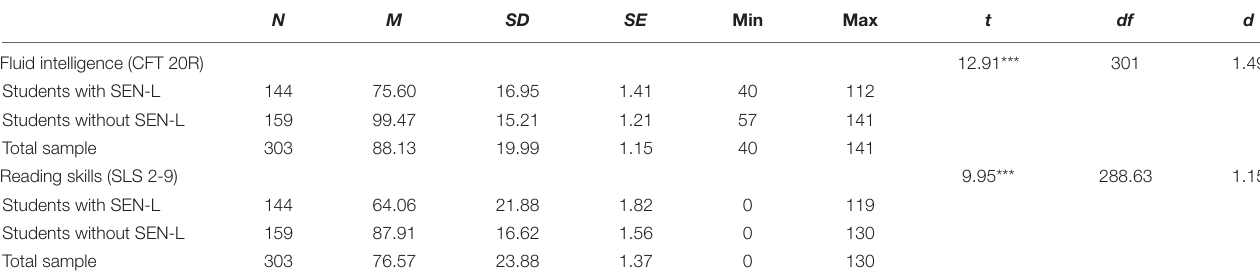
TABLE 2 | Descriptive Statistics and independent sample t -test for group differences in fluid intelligence and reading skills. N M SD SE Min